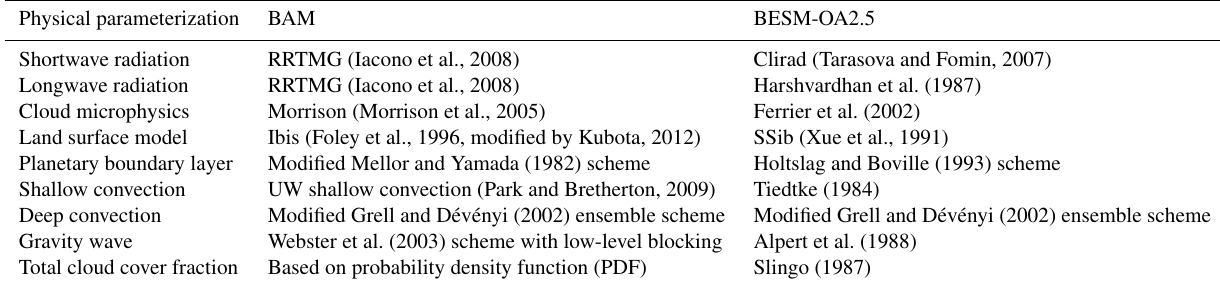
Table 1. Atmospheric physical parameterizations used in BAM (Figueroa et al., 2016) BESM-OA2.5. Physical parameterization BAM BESM-OA2.5 Shortwave radiation RRTMG (Iacono et al., 2008) Clirad (Tarasova and Fomin, 2007) Longwave radiation RRTMG (Iacono et al., 2008) Harshvardhan et al. (1987) Cloud